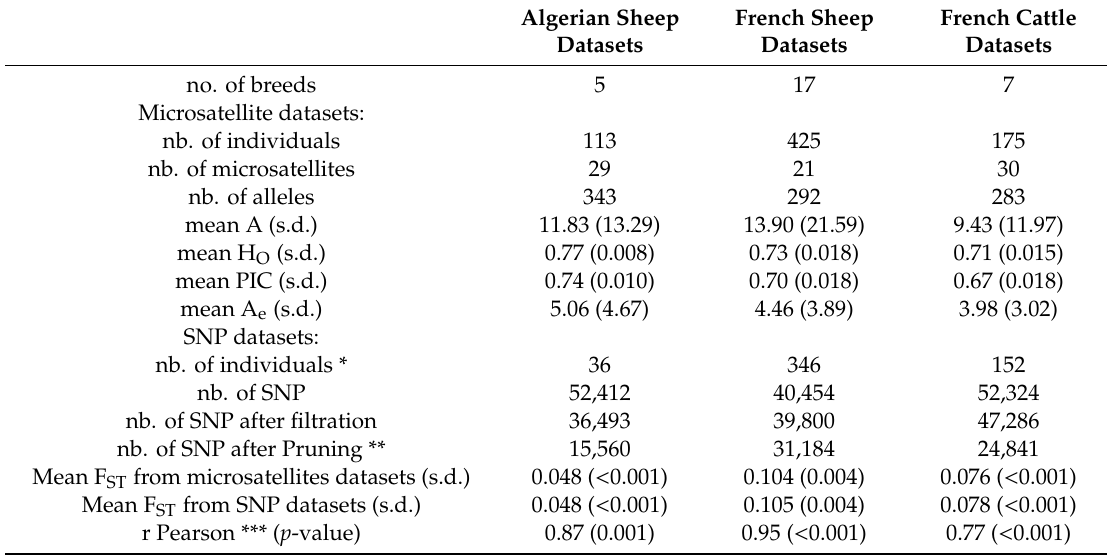
Table 1. Genetic diversity measured by